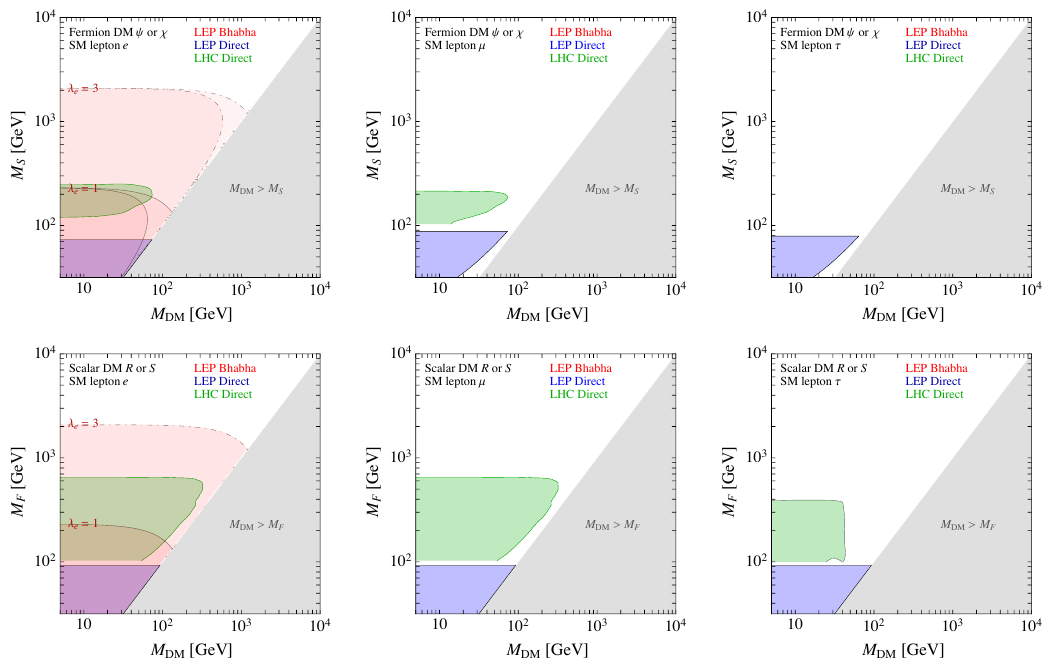
Figure 9 . Collider constraints for fermion (upper panel) and scalar DM (lower panel) for UV models couplings to right-handed electrons, muon and taus. The grey area in the M DM plane is excluded by DM stability, while the colored regions are excluded by direct searches at LHC (green) and LEP (blue). For DM coupling to electrons one has also constraints from Bhabha scattering at LEP-2 (red), which we display for di(cid:11)erent values of the coupling (cid:21) e = 1 (solid) and (cid:21) e = 3 (dashed). These constraints do not apply to real scalar DM, and for fermions are di(cid:11)erent for Dirac (light red) and Majorana (dark red)